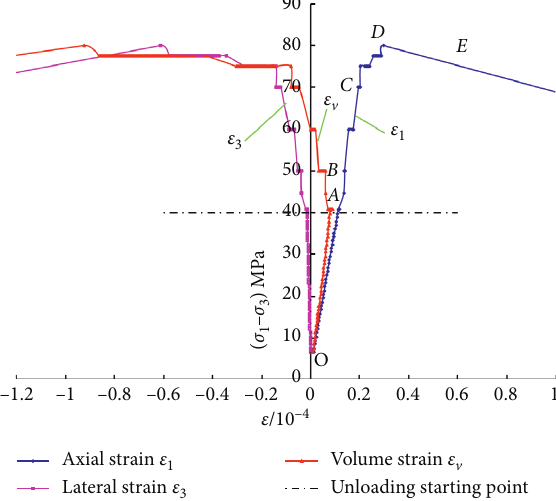
Figure 3: Triaxial compression stress ( σ granite under different confining pressures.